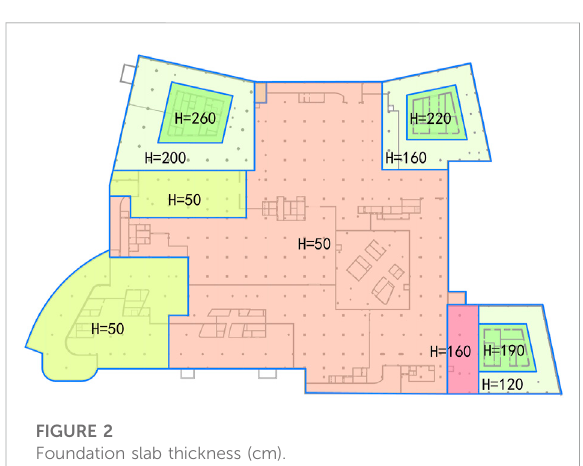
FIGURE 2 Foundation slab thickness